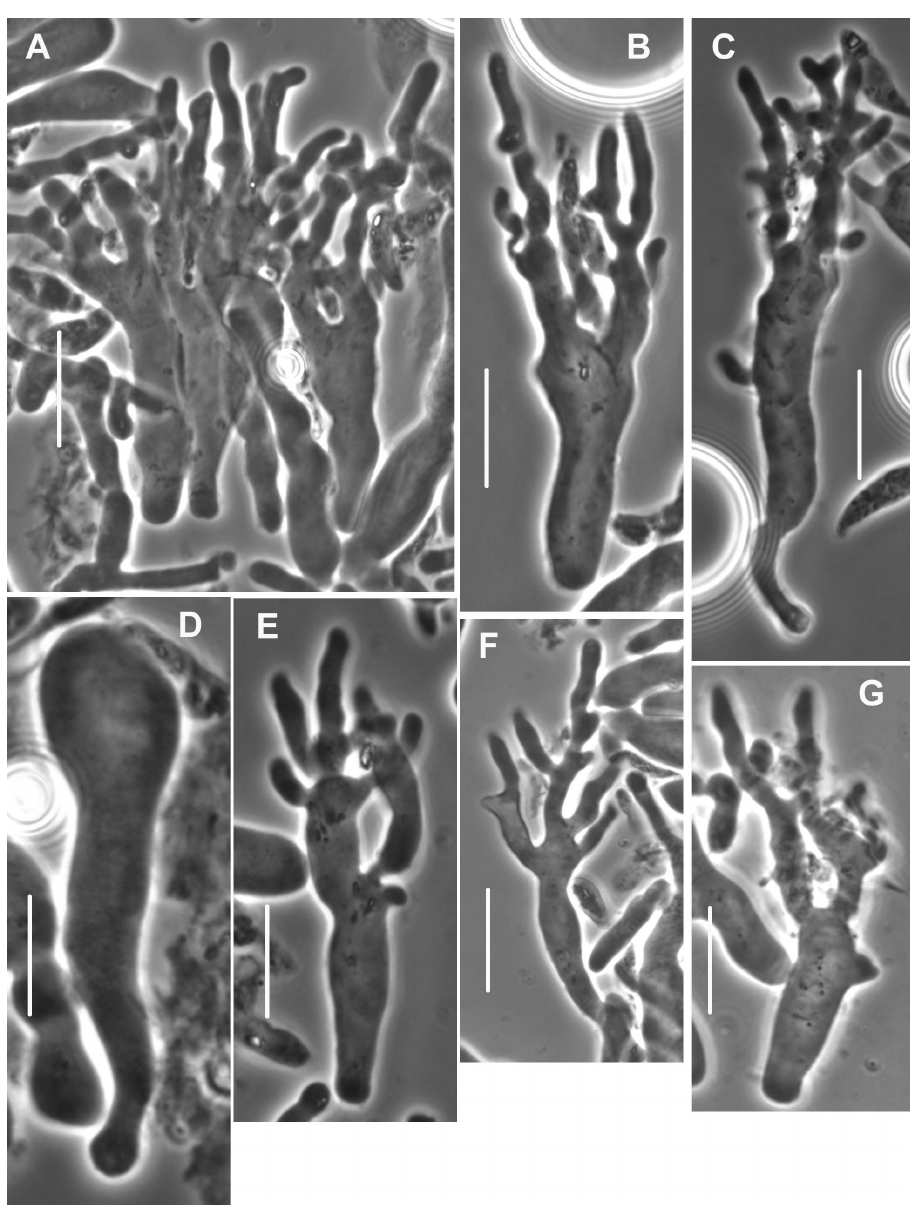
Figure 68. Mycetinis salalis . Cheilocystidia. A Cluster of cheilocystidia B, C, E–G Individual branched cheilocystidia D Clavate, unornamented element. Standard bars = 10 µm. TFB 5724 (TENN 52572).